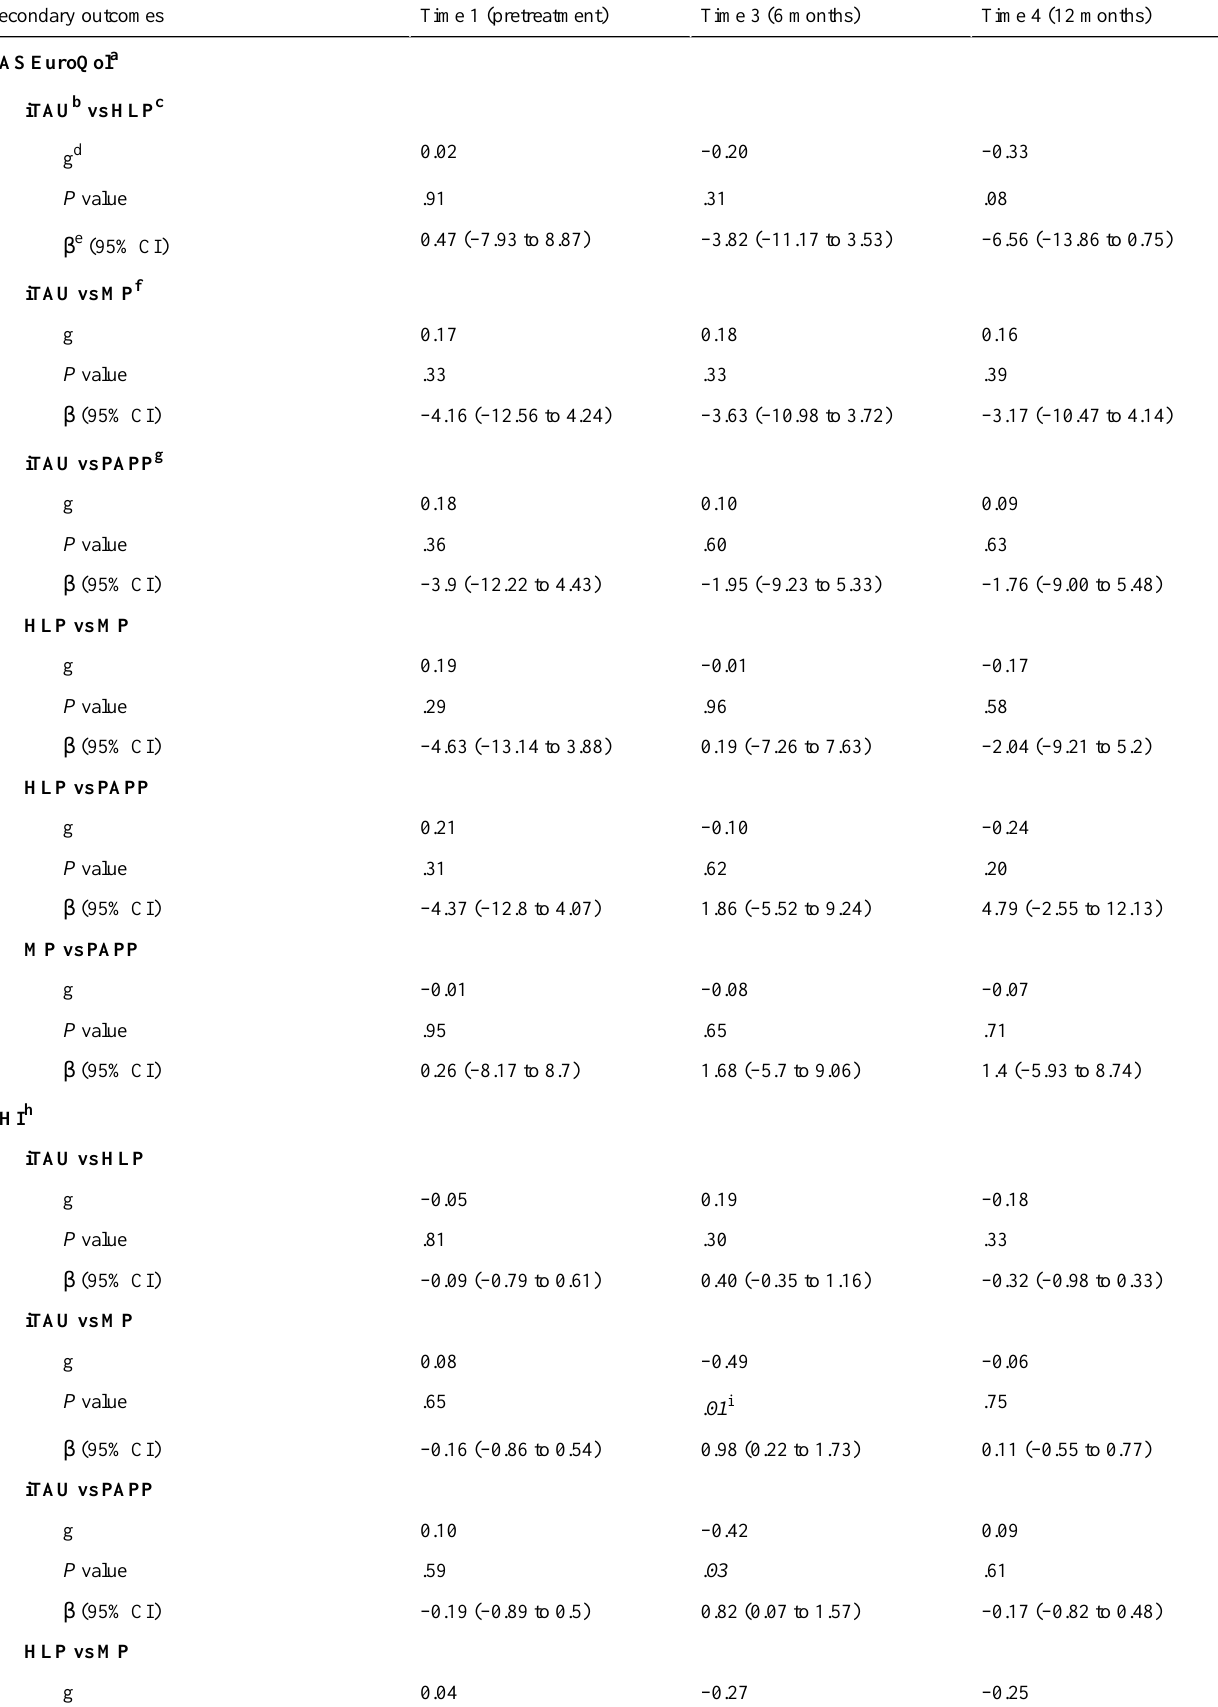
Table 6. Visual analog scale of the EuroQol and Pemberton Happiness Index outcome analysis with imputed data (N=221): intervention comparisons along the